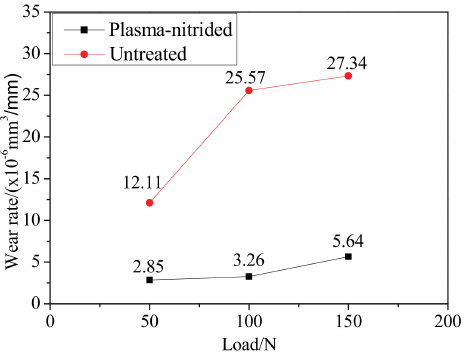
Figure 15. The wear rates of untreated specimens and plasma-nitrided specimens under di ff erent loads at the sliding speed of 83.3 mm / s.